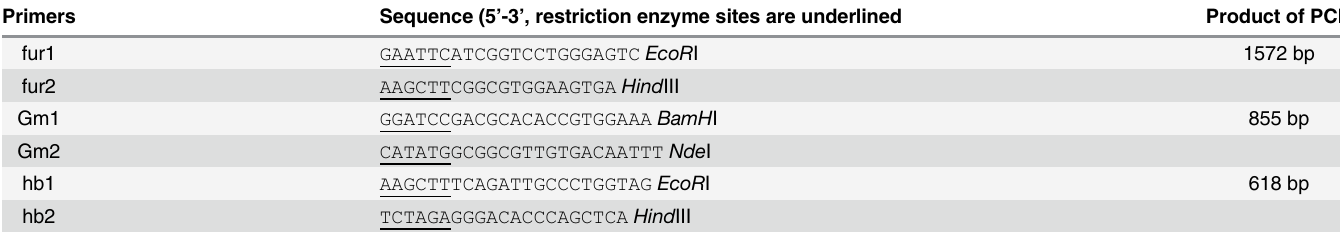
Table 2. PCR primers used in this study.